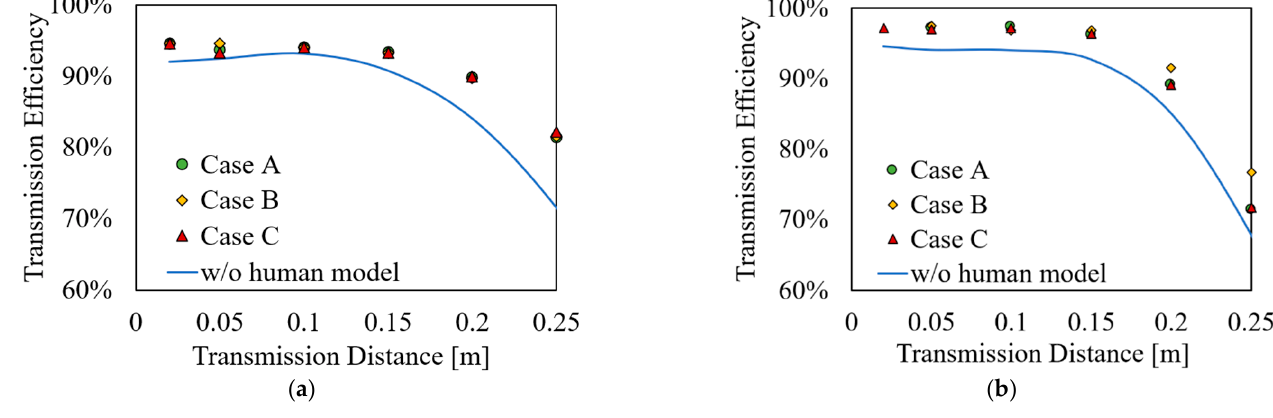
Figure 7. Dependence of transmission efficiency on d in Case A ( l = 0), Case B ( l = d /2), and Case C ( l = d ), and without a human model for a ( a ) non-grounded and ( b ) grounded resonator.